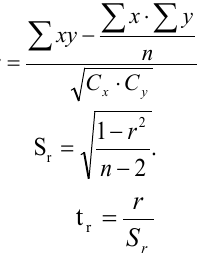
Live weight at the time of birth, kg Live weight at the age of 2 months, kg Live weight at the age of 4 months, kg